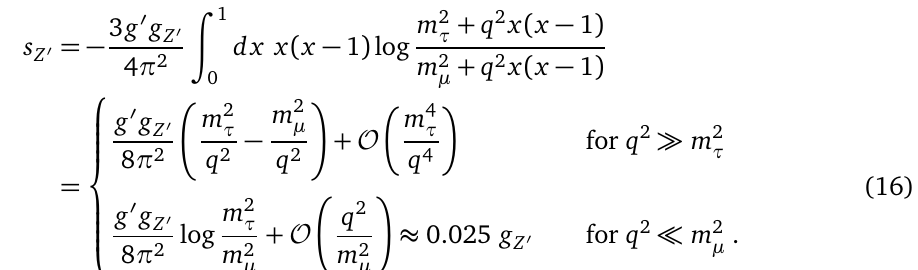
Figure 3: Branching ratios for the U ( 1 ) λ = 0.1, g = 1, and s HS Z (cid:48)